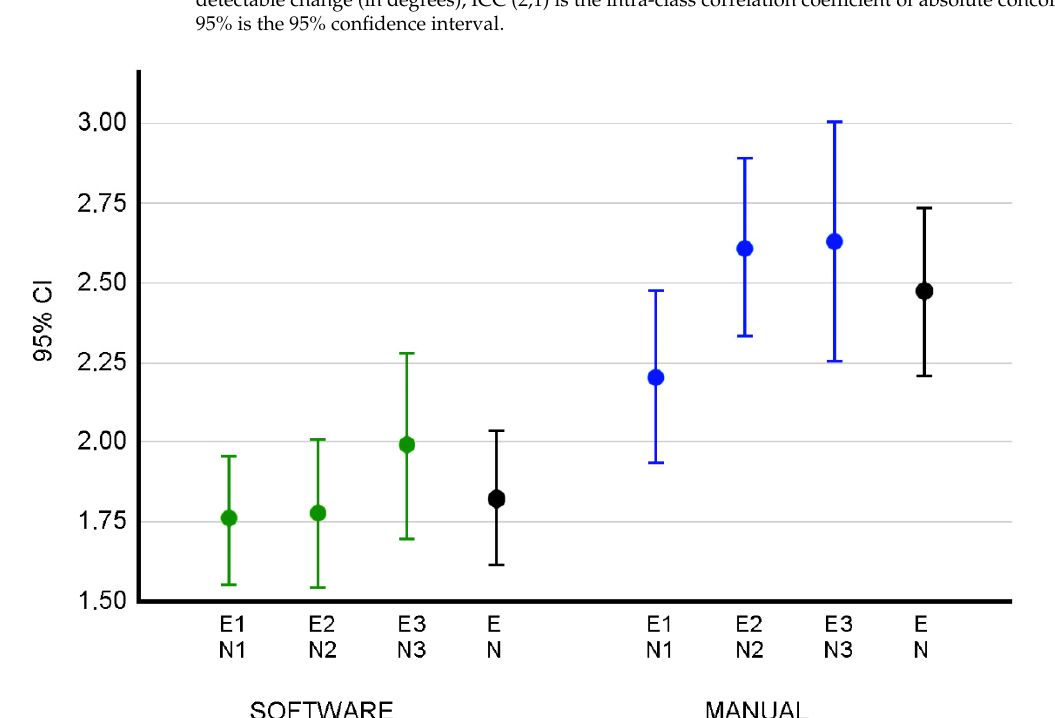
Table 1. The intra- and inter-group validity and reliability analysis with the software and manual